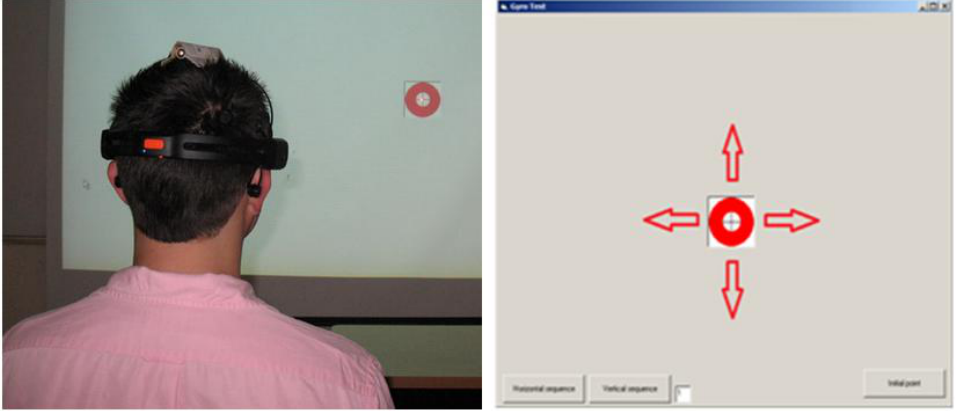
Figure 15. Experimental setup of EEG-based mouse emulation.